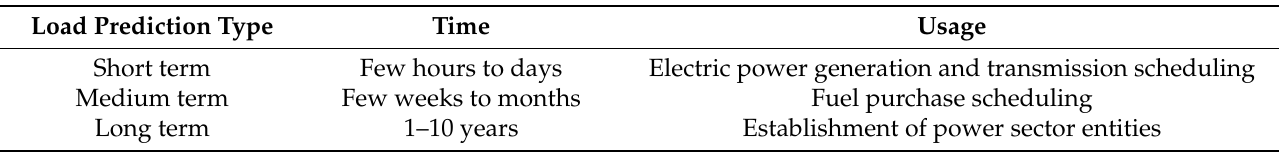
Table 1. Active power load prediction classification.